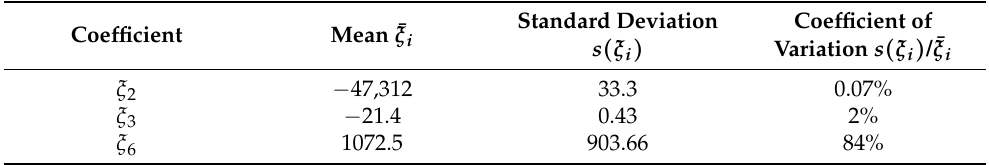
Table 5. Mean value, standard deviation, and coefficient of variation of the identified coefficients by using impulse